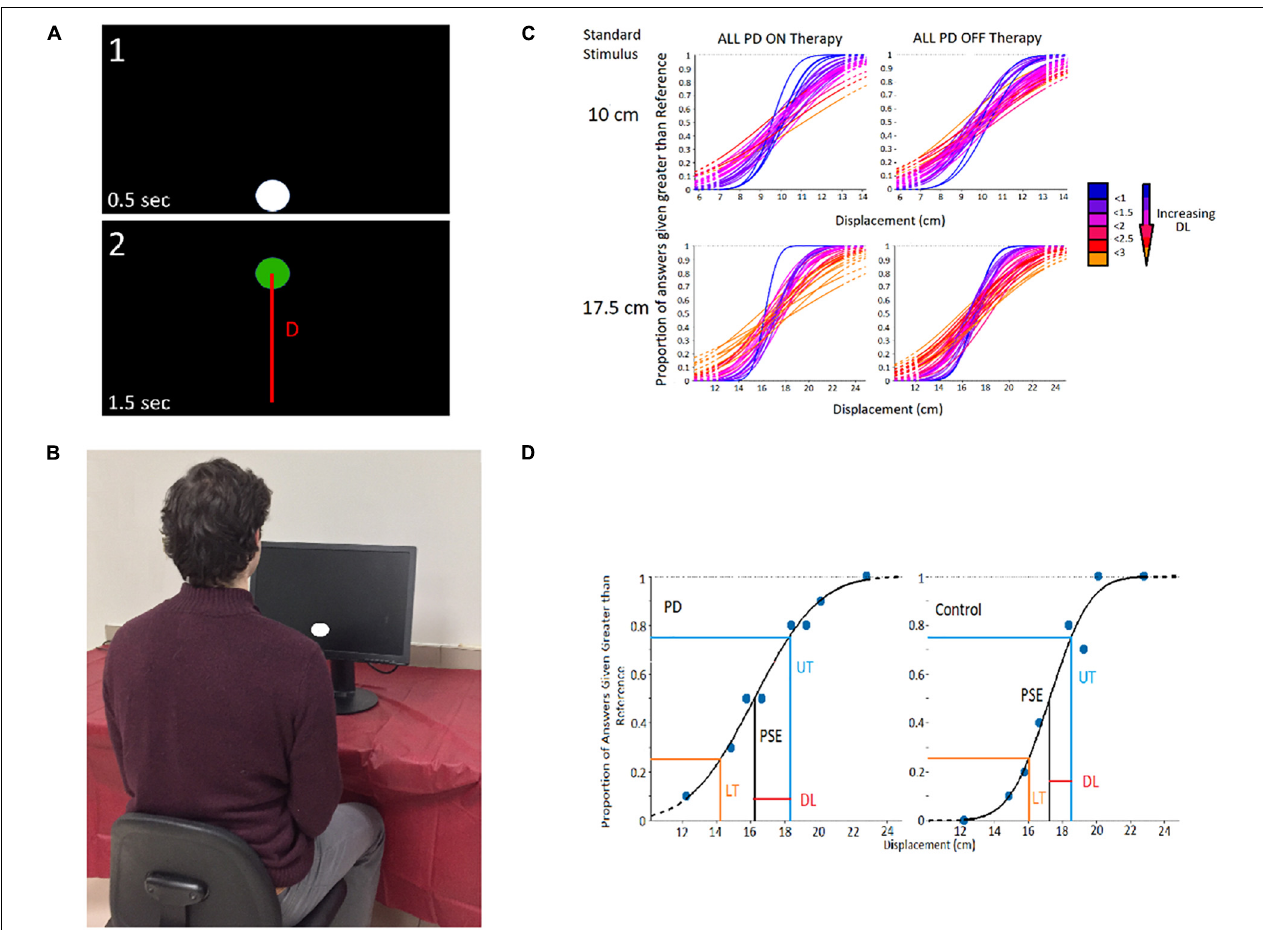
FIGURE 1 | Experimental Design. (A) Visual Displacement Perception Trial — Participant compares displacement distance between circles (D; line not visible in the experiment). (B) Experimental Setup. (C) Cumulative Gaussian Distributions heat map of PD participants and controls, in which distributions more blue in colour signify a greater slope (thus greater participant perceptual sensitivity), and those more red/orange in colour signifying a lesser slope (and worse participant perceptual ability). (D) Example analysis of Cumulative Gaussian Distribution to obtain